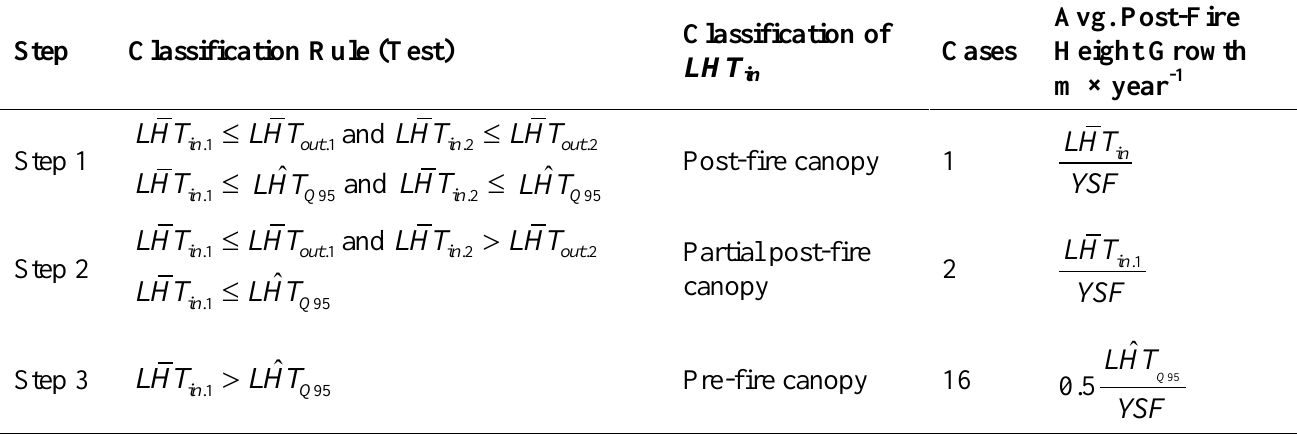
, or LHT or both failed the diptest of a single in out